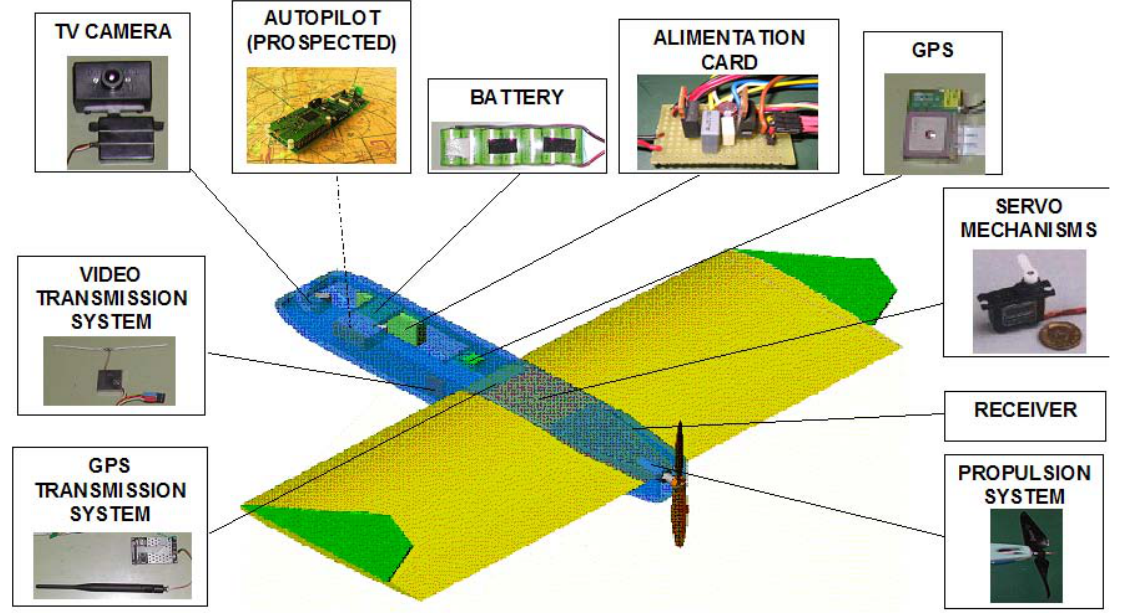
Fig 5. Layout of on-board systems of Mini-UAV